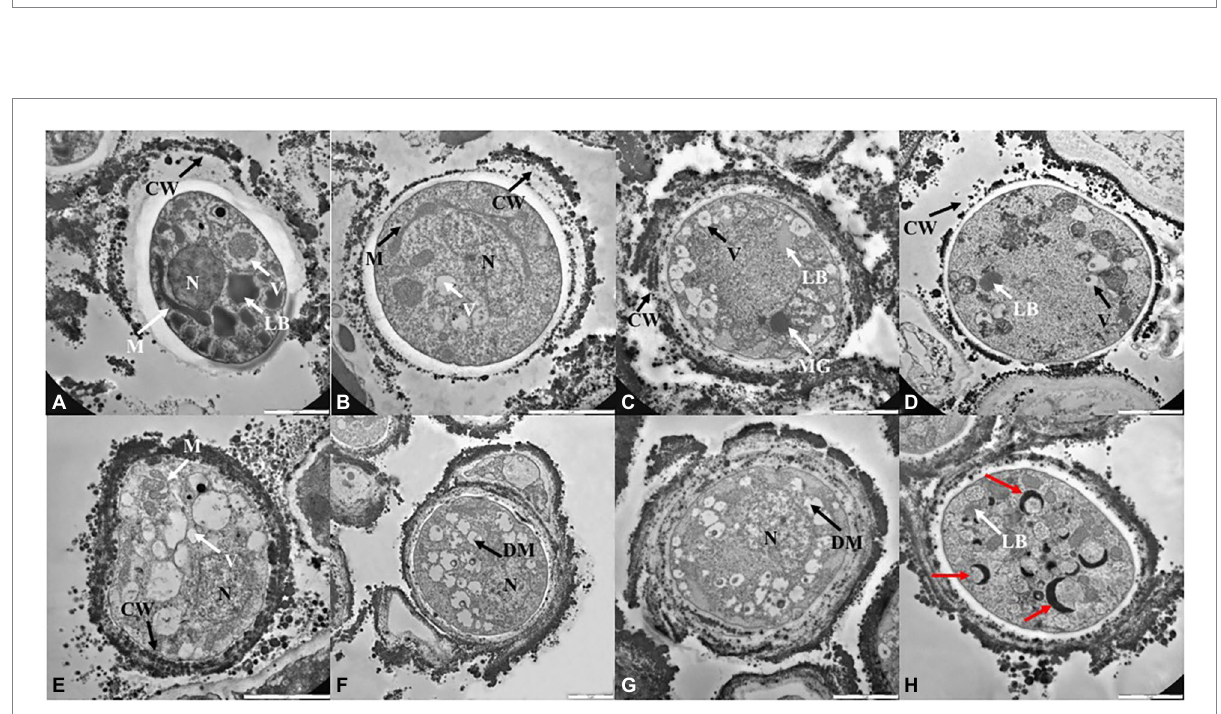
FIGURE 4 TEM images of C. antarcticus cells grown on (A) MEA (no salt, control), (B) 50 mM, (C) 150 mM and (D) 220 mM of Na-perchlorate; (E) MEA (no salt, control), (F) 50 mM, (G) 80 mM and (H) 90 mM of K-perchlorate. Scale bar: 2 μ m. N, nucleus; M, mitochodrion; DM, damaged mitochodrion; CW, cell wall; LB, lipid body; V, vacuoles; MG, melanin granules; red arrow, cell wall